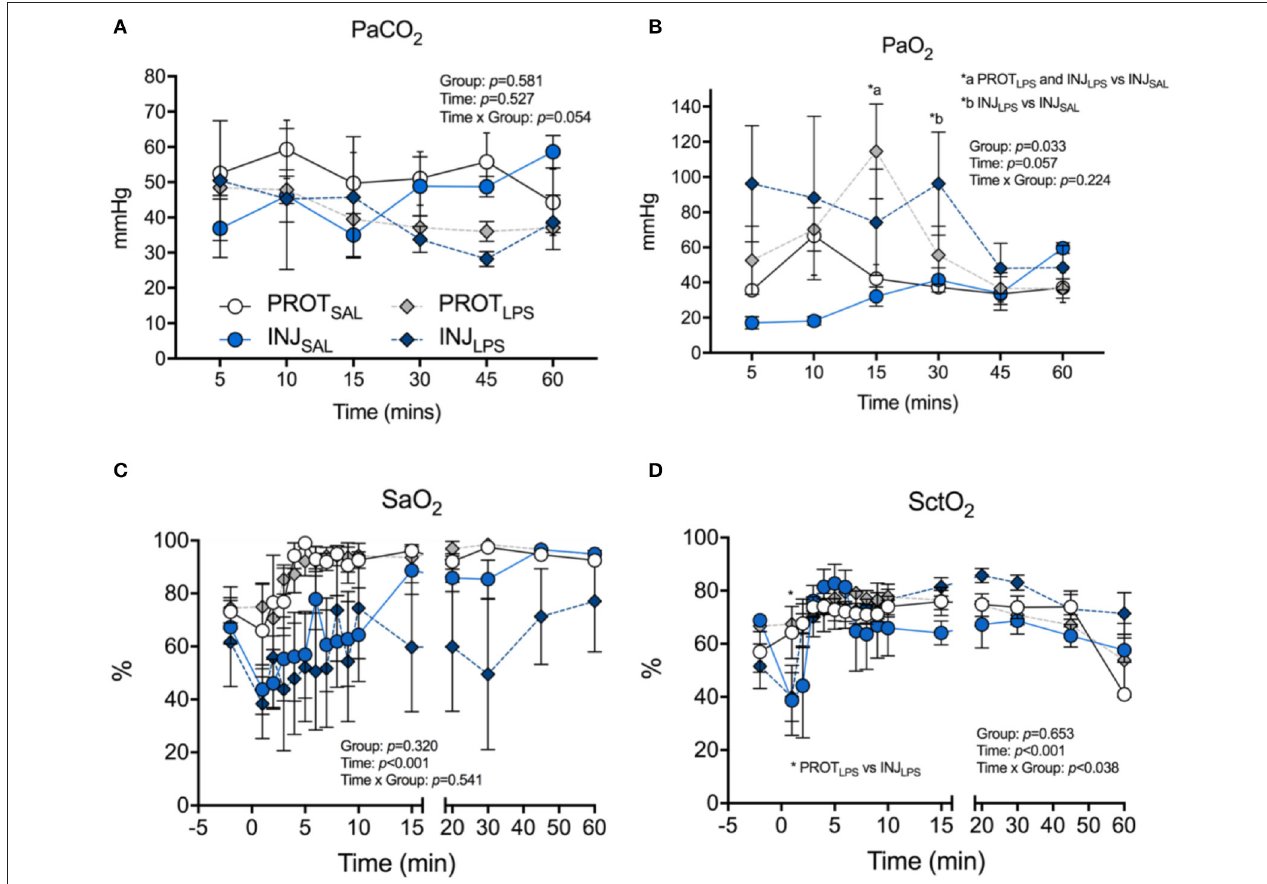
FIGURE 2 | Effects of ventilation strategy and LPS exposure on blood gases and oxygen saturation. Changes in partial pressure of CO 2 (PaCO 2 ) (A) , and partial pressure of O 2 (PaO 2 ) (B) in arterial blood, arterial oxygen saturation (SaO 2 ) (C) , and cerebral tissue O 2 saturation (SctO2) (D) in the PROT SAL , INJ SAL , PROT LPS and INJ LPS lambs. PROT SAL , N = 5; PROT LPS , N = 6; INJ SAL , N = 6; and INJ LPS , N = 5. * p <